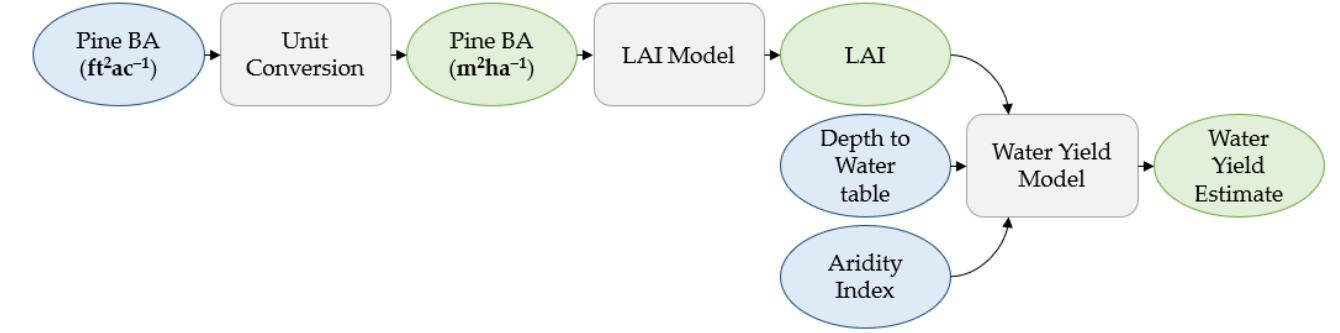
Figure 5. Graphical depiction of the spatially explicit water yield